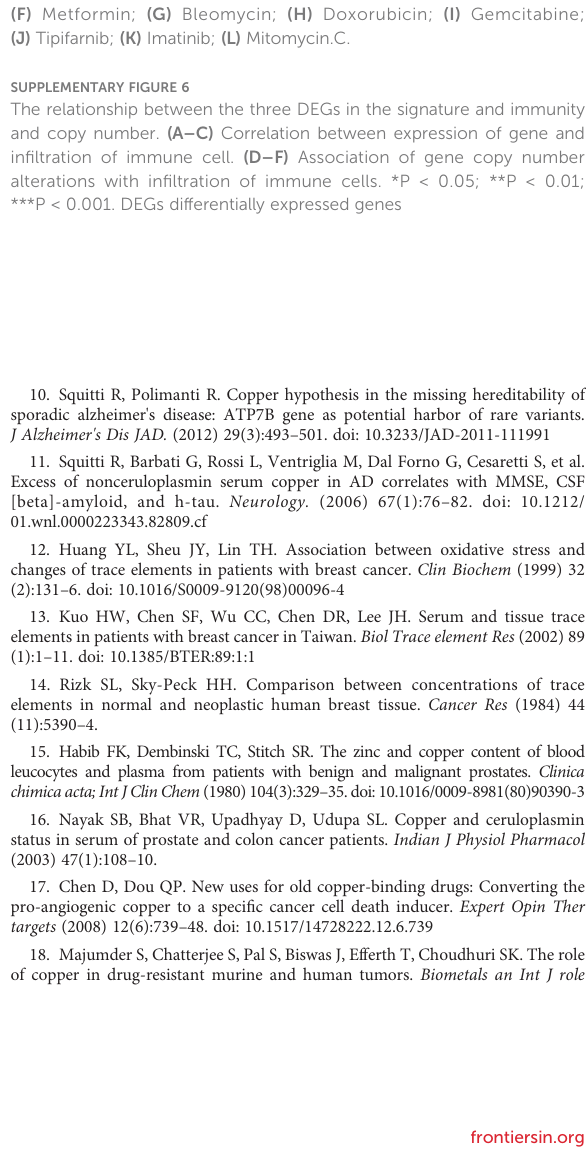
SUPPLEMENTARY FIGURE 1 Curves of K-M for OS in the groups with high and low expression of 10 cuproptosis regulators. (A) FDX1; (B) LITP1; (C) LIAS; (D) DLD; (E) DLAT; (F) PDHA1; (G) PDHB; (H) MTF1; (I) GLS; (J) CDKN2A. K-M Kaplan-Meier, OS overall survival SUPPLEMENTARY FIGURE 2 Cuproptosis clustering. (A – G) Consensus matrix based on cuproptosis regulator expression in the HCC cohort at k = 2 - 9. (H) Consensus CDF plots for cuproptosis clustering. (I) The area under the CDF curve relative changes for cuproptosis clustering SUPPLEMENTARY FIGURE 3 Gene clustering (A – G) Consensus matrix based on cuproptosis-related gene expression in the HCC cohort at k= 2-9. (H) Consensus CDF plots for gene clustering. (I) The area under the CDF curve relative changes for gene clustering. HCC hepatocellular carcinoma, CDF cumulative distribution function SUPPLEMENTARY FIGURE 4 Comparison of risk scores within different grades or between different classi fi cations of clinicopathological features. (A) Stage; (B) T; (C) Grade; (D) AFP expression; (E) Sex; (F) Age. SUPPLEMENTARY FIGURE 5 Comparison of drug sensitivity between groups with high and low risk. (A) Ge fi tinib; (B) Sorafenib; (C) Nilotinib; (D) Dasatinib; (E) Erlotinib; (F) Metformin; (G) Bleomycin; (H) Doxorubicin; (I) Gemcitabine; (J) Tipifarnib; (K) Imatinib; (L) Mitomycin.C. SUPPLEMENTARY FIGURE 6 The relationship between the three DEGs in the signature and immunity and copy number. (A – C) Correlation between expression of gene and in fi ltration of immune cell. (D – F) Association of gene copy number alterations with in fi ltration of immune cells. *P < 0.05; **P < 0.01; ***P < 0.001. DEGs differentially expressed